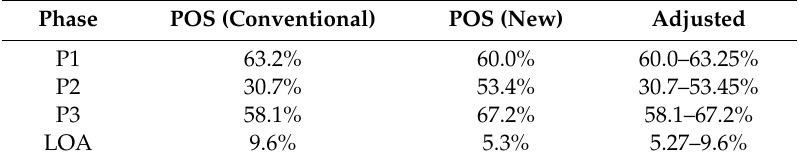
Table 17. Refined POS scope by BLA development phase for the whole period (1970–2017).